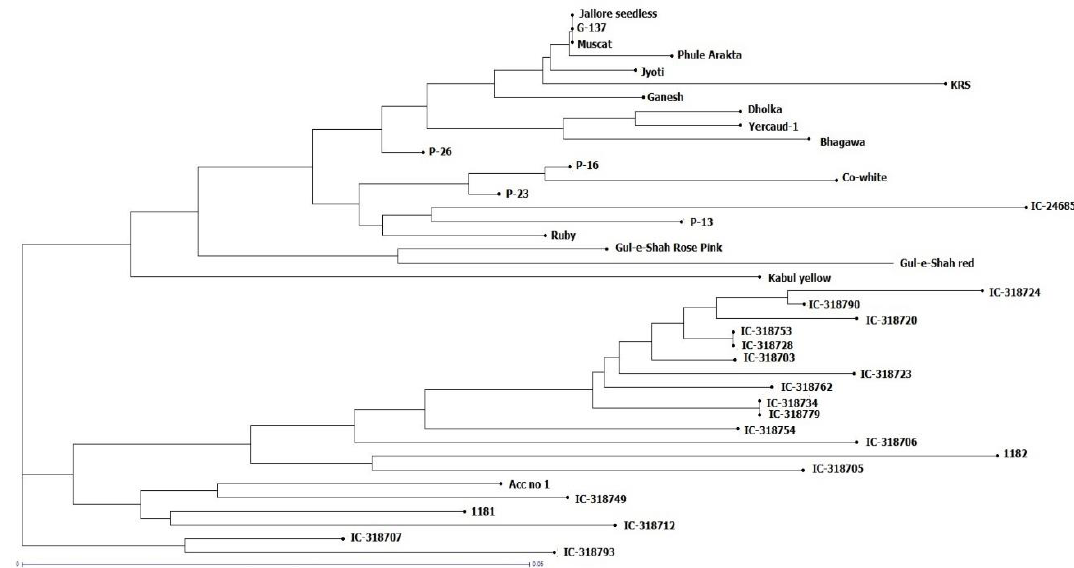
Figure 3. Neighbor-joining clusters of 40 pomegranate accessions generated by SSR markers using the dissimilarity coefficient.